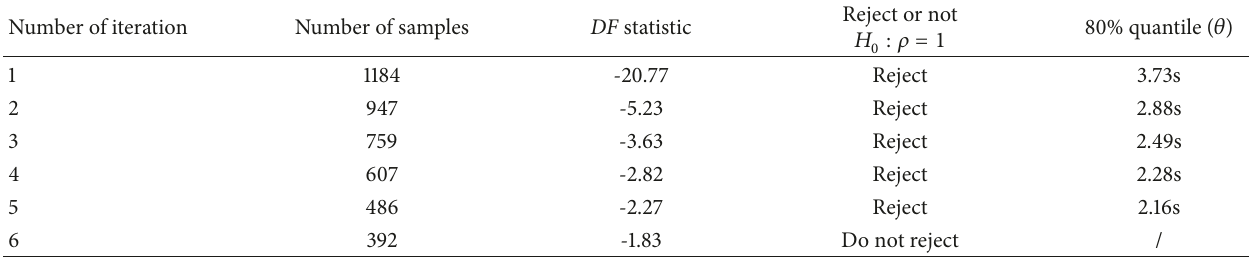
Table 4: Applying the iterative method using samples from lane 2.